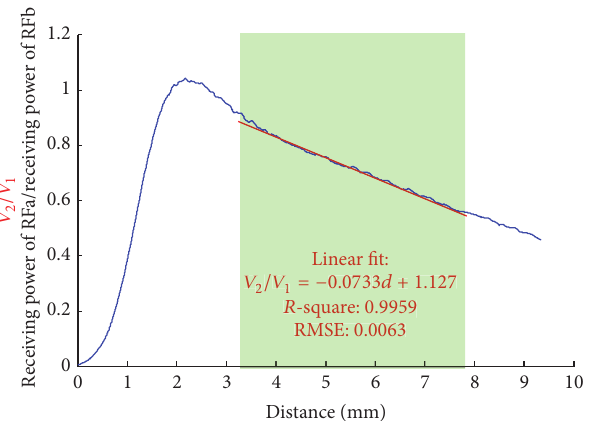
Figure 9: Displacement measurement calibration.